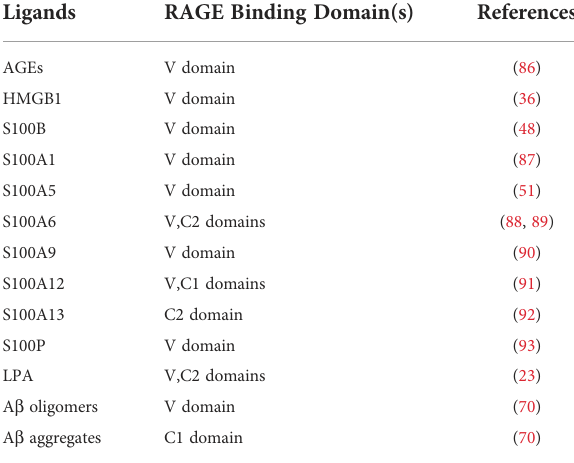
TABLE 1 A few major types of RAGE ligands and RAGE binding